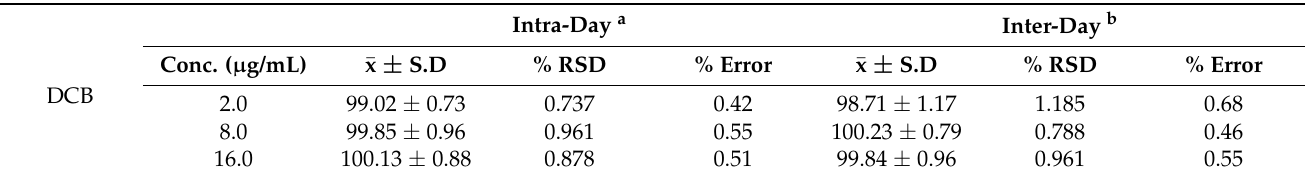
Table 3. Intra- and inter-day precision data for the determination of DCB by the proposed method.